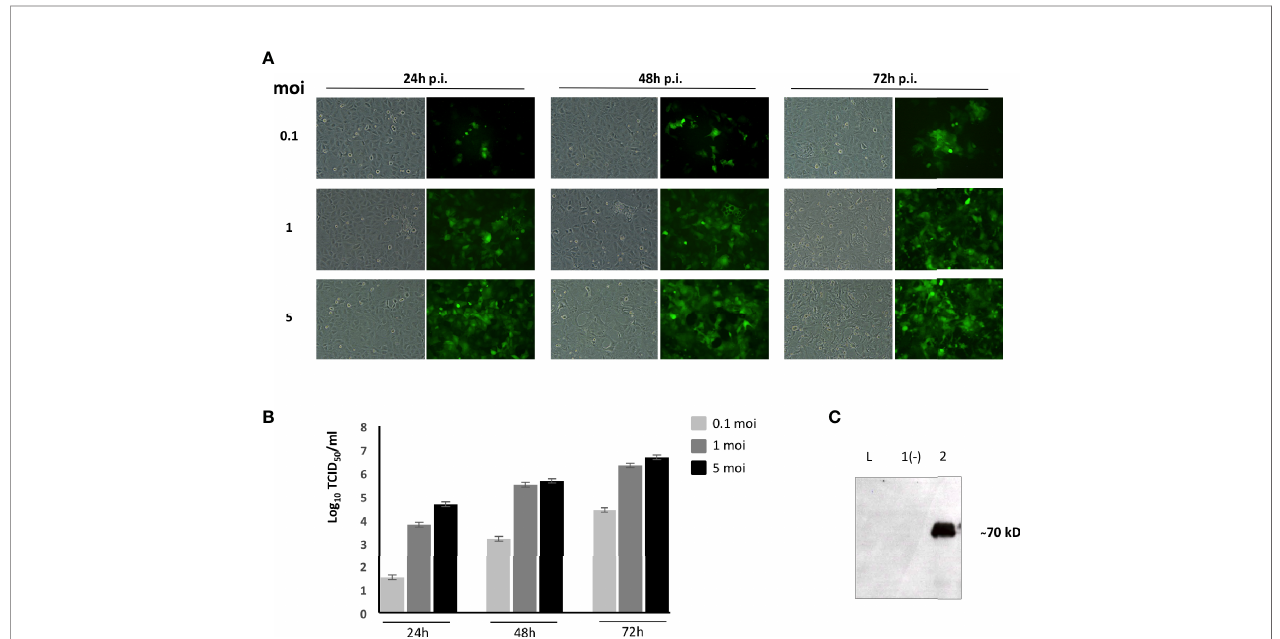
FIGURE 1 | BoHV-4-A-PPRV-H- D TK adaptation and characterization in ovine fetal lungs (OFLs). (A) Representative images of BoHV-4-EFGP D TK-infected OFLs with different moi at 24, 48, and 72 h post-infection. Magni fi cation, ×10 (all panels). (B) Viral titer was measured and expressed as Log10 TCID 50 per ml of viral particles released at 24, 48, and 72 h post-infection when infected with 0.1, 1, or 5 moi, respectively. Values shown are the means ± standard errors of three independent experiments. (C) Western immunoblotting of OFL cells, infected with BoHV-4-A-PPRV-H- D TK (lane 2) or the parental BoHV-4-A D TK used as a negative control (lane 1). (L) Mass ladder. The lanes were loaded with the same amount of total protein.